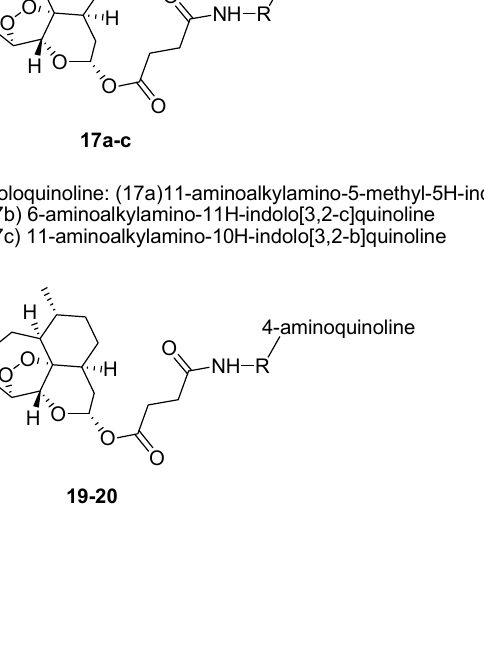
Figure 3. Quinoline-artemisinin hybrids.